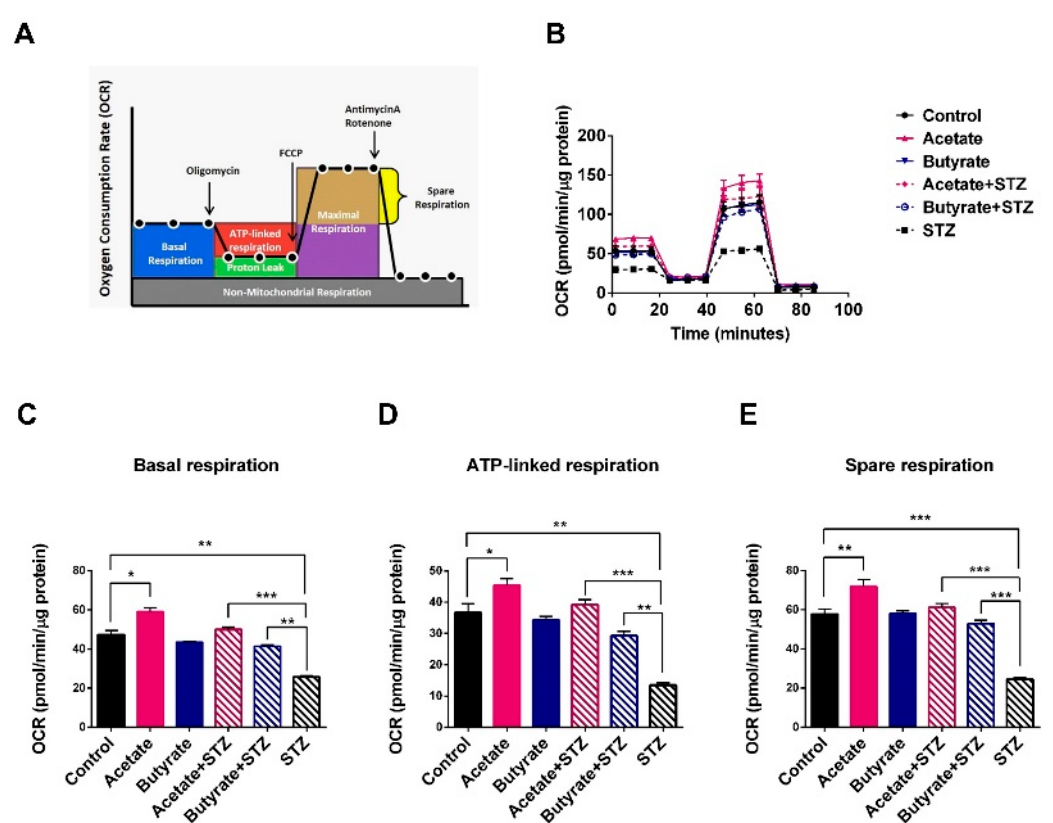
Figure 4. Effects of acetate and butyrate on oxygen consumption rate (OCR) of MIN6-cells. ( A ) A schematic overview of the mitochondrial stress test. Arrows indicate the subsequent addition of the ATPase inhibitor oligomycin, the uncoupling reagent phenyl hydrazone (FCCP), and the inhibitors of the electron transport chain rotenone/antimycin A. ( B ) MIN6 cell were seeded in a Seahorse cell culture plate; after incubation with 1 mM of acetate or butyrate, STZ at a final concentration of 5 mM was added to each well and incubated for 24 h. The OCR of each treated cell was investigated using a Seahorse Biosience XF24 extracellular flux analyzer. Figures C – E respectively represent individual parameters for basal respiration ( C ), ATP-linked respiration ( D ), and spare respiration ( E ). Results are plotted as mean ± SEM ( n = 5). The statistical differences were quantified using one-way ANOVA analysis with Newman–Keuls multiple comparisons test (* p < 0.5, ** p < 0.01, *** p < 0.001).